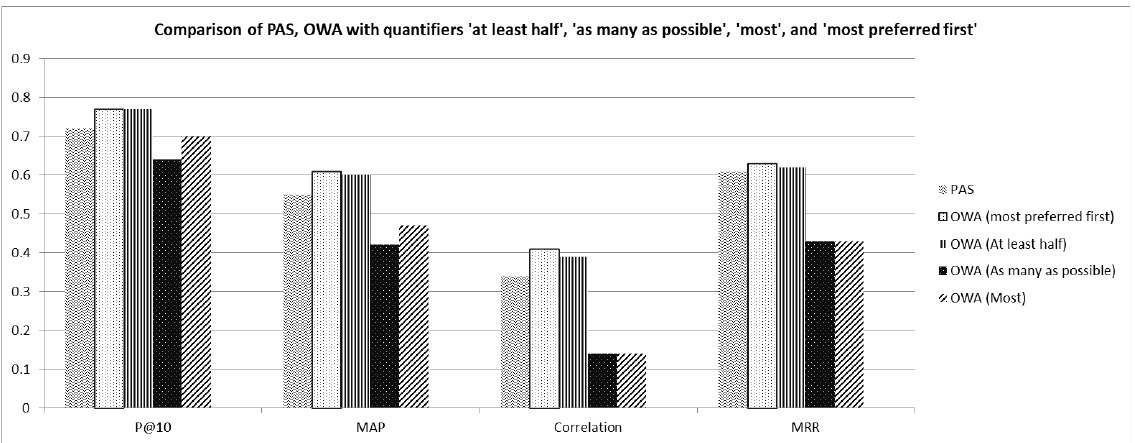
Figure 4. Performance evaluation scheme for the book recommendation approach.